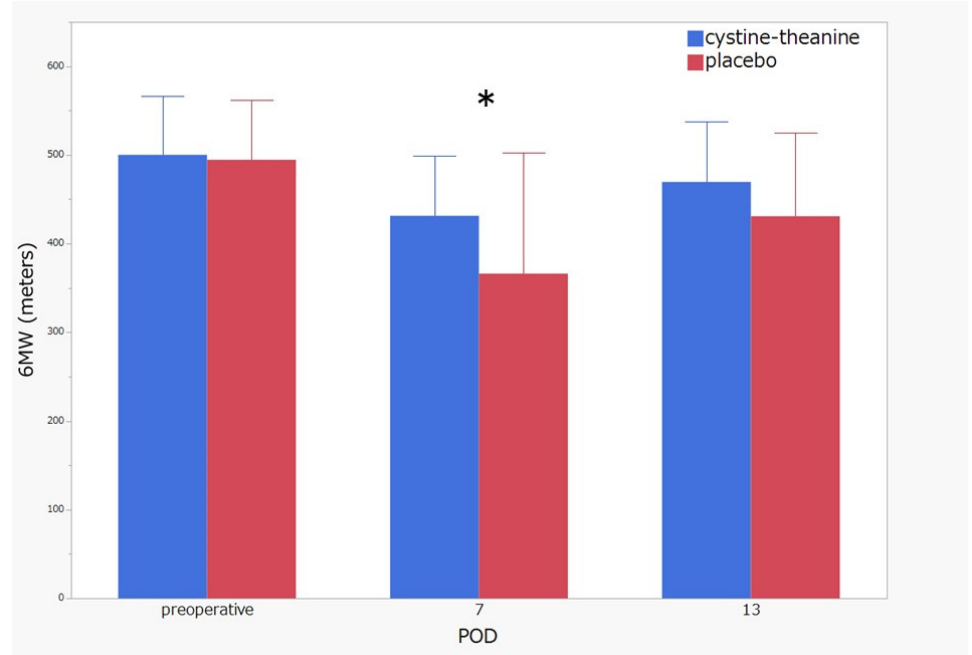
Figure 5. A 6 min walk test (6MWT). 6MWT on POD 7 in the CT group was significantly higher than that in the placebo group. * p < 0.05.